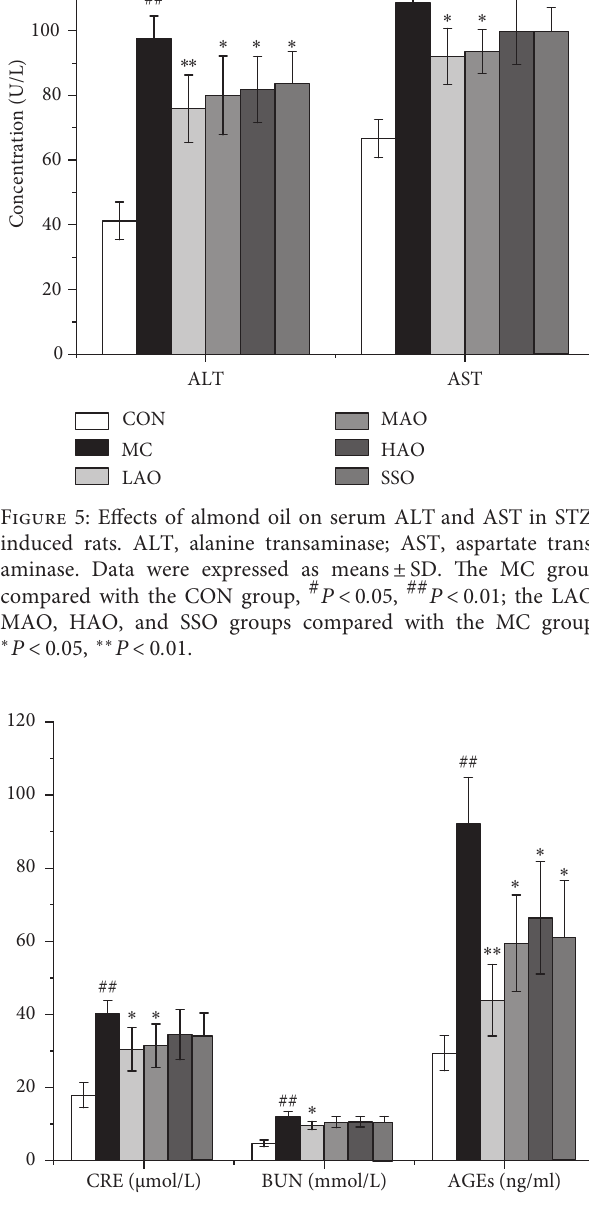
CRE (µmol/L) BUN (mmol/L)